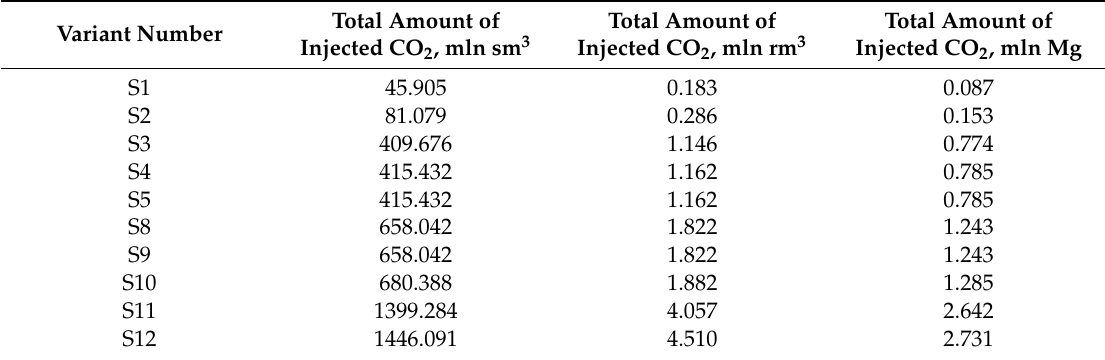
Table 8. Comparison of the results obtained for the total amount of CO 2 injected in particular simulation variants in the model of the Upper Silesian Sandstone Series.